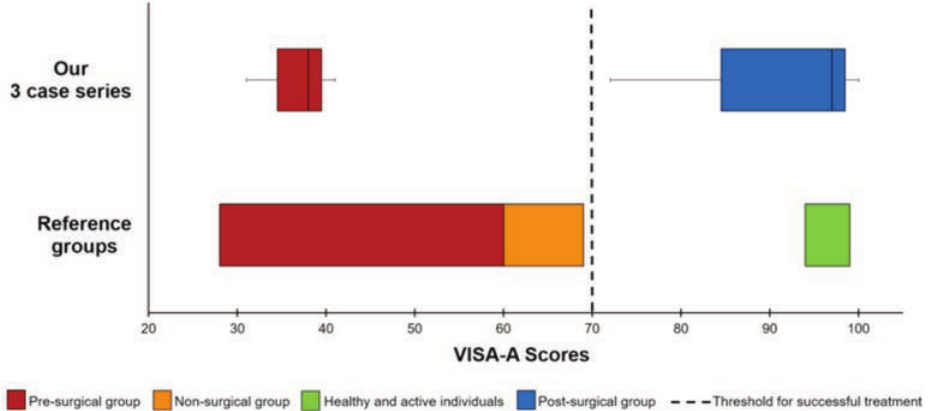
Diagram showing VISA-A scores of different groups; namely pre-surgical, non-surgical, healthy and active individuals, and post- Fig. 3: surgical. The upper bars represent the scores from our three-case series. The lower bars indicate reported scores, whereby the dotted line is the threshold score that indicate treatment success (Robinson et al , 2001) 4